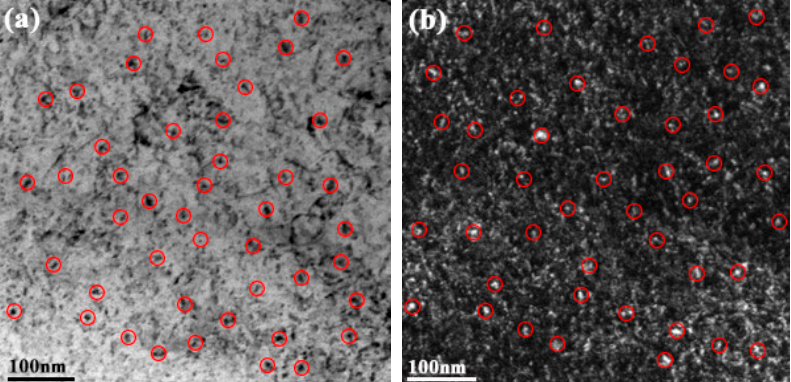
Figure 3. ( a ) [Ti], wt % and [O], wt % contents and ( b ) total molar amount, mol of Ti 3 O 5 as a function of temperature(in °C) in Ti 0.05 wt %-O 0.0020 wt % system.